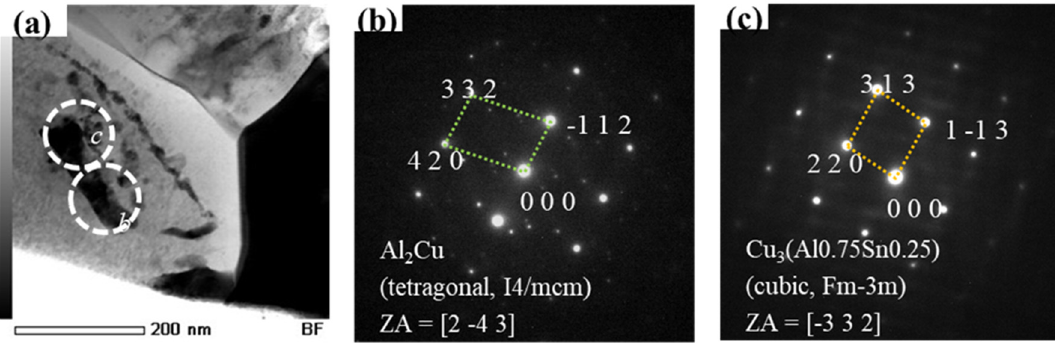
Figure 11. ( a ) TEM bright-field image of the interfacial microstructure for the SC-0.03Al(Si) solder joint. Selected area electron diffraction patterns for ( b) Al 2 Cu and ( c ) Cu 3 (Al 0.75 Sn 0.25 ) [27].